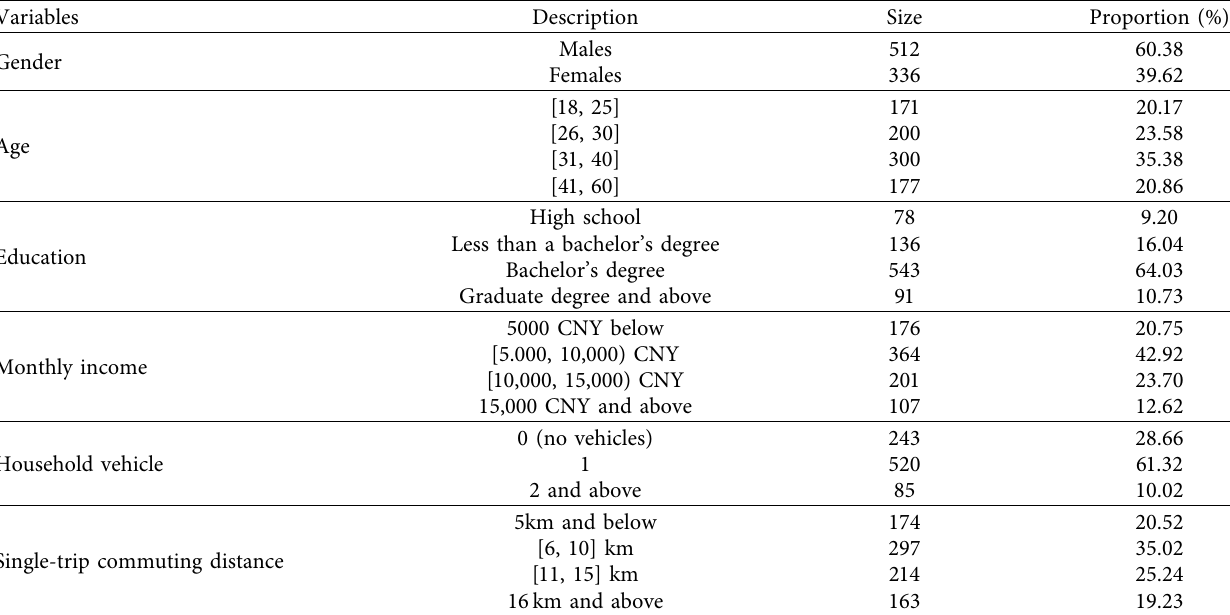
Table 2: Detail of sample